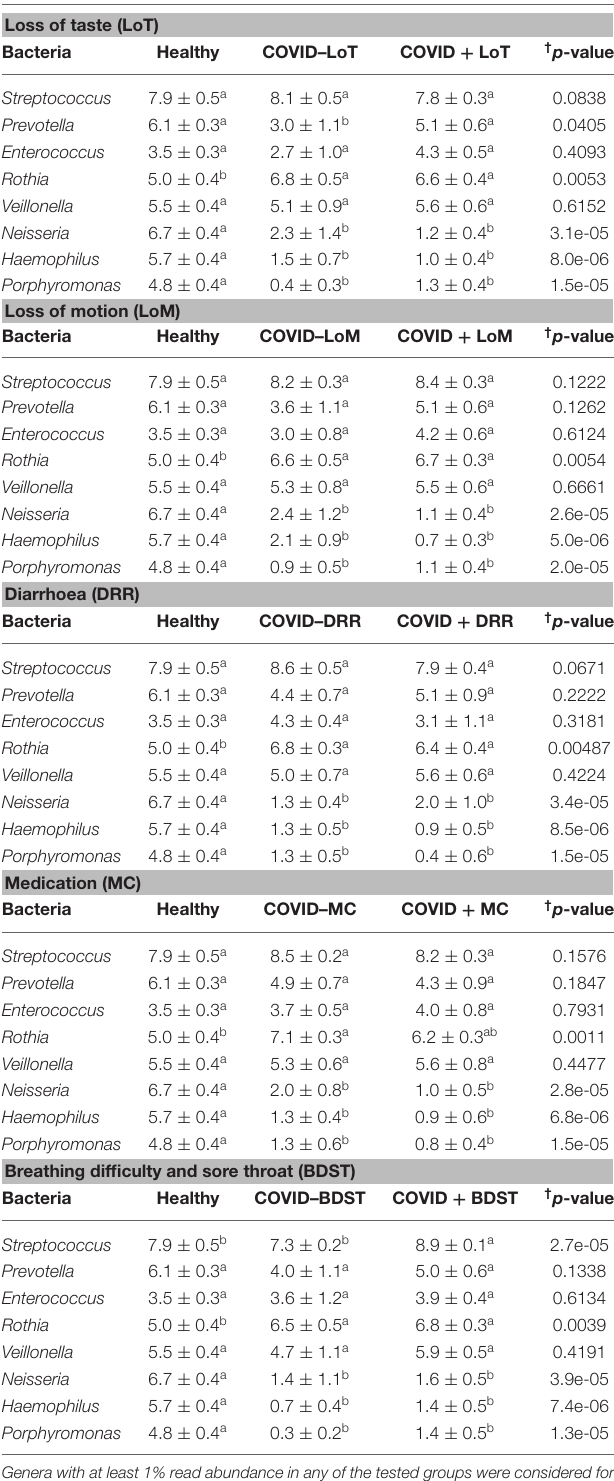
Genera with at least 1% read abundance in any of the tested groups were considered for thedifferentialabundanceanalysis.Relativeabundanceisshownasmean ± SD.Different superscripts ( a , b , ab ) placed with mean values in the same column convey their significant difference in bacterial abundance with each other. † p-value adjusted with Bonferroni